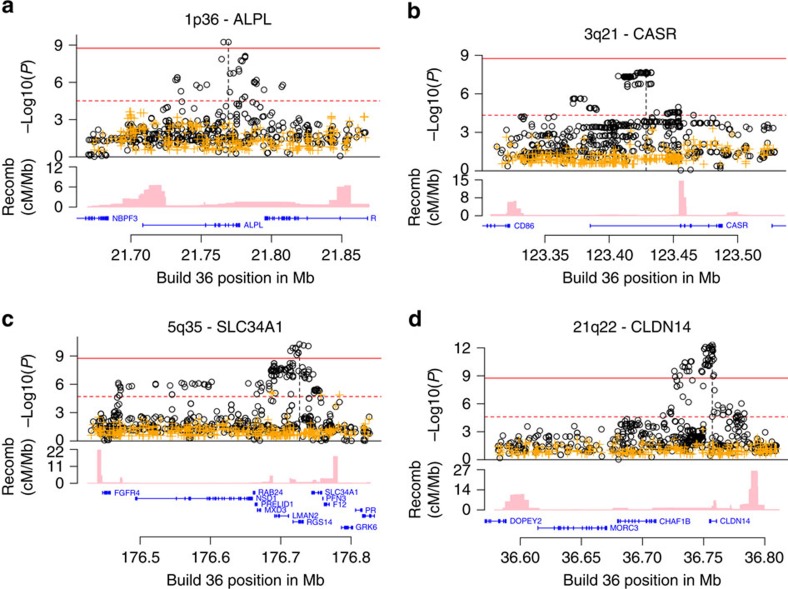
Locus plots corresponding to genome-wide significant and suggestive loci associating with kidney stoneLogistic regression was used for association testing between sequence variants and disease, treating disease status as the response and genotype counts as covariates (a–d) For each plot, the −log10 P values, derived by logistic regression, (y axis) for the sequence variants are shown according to their chromosomal positions (x axis). The significant loci are at 1p36 (a), 5q35 (c), 21q22 (d) and suggestive locus at 3q21 (b). Orange sequence variant colour represent association values after adjusting for the leading variant. Estimated recombination rates are shown as pink lines and the genomic locations of genes at the locus are depicted in blue. The red solid line indicates the threshold for genome-wide statistical significance, which takes into account the effects of multiple testing (P=0.05/28.3 million=1.8 × 10−9). The red broken line indicates the significance threshold for claiming independence of the index varaint based on the number variants located within the LD block containing the index variant at each locus (ALPL; 0.05/1,625=3.1 × 10−5, CASR; 0.05/1,078=4.6 × 10−5, SLC34A1; 0.05/2,516=2.0 × 10−5, CLDN14; 0.05/1,993=2.5 × 10−5).